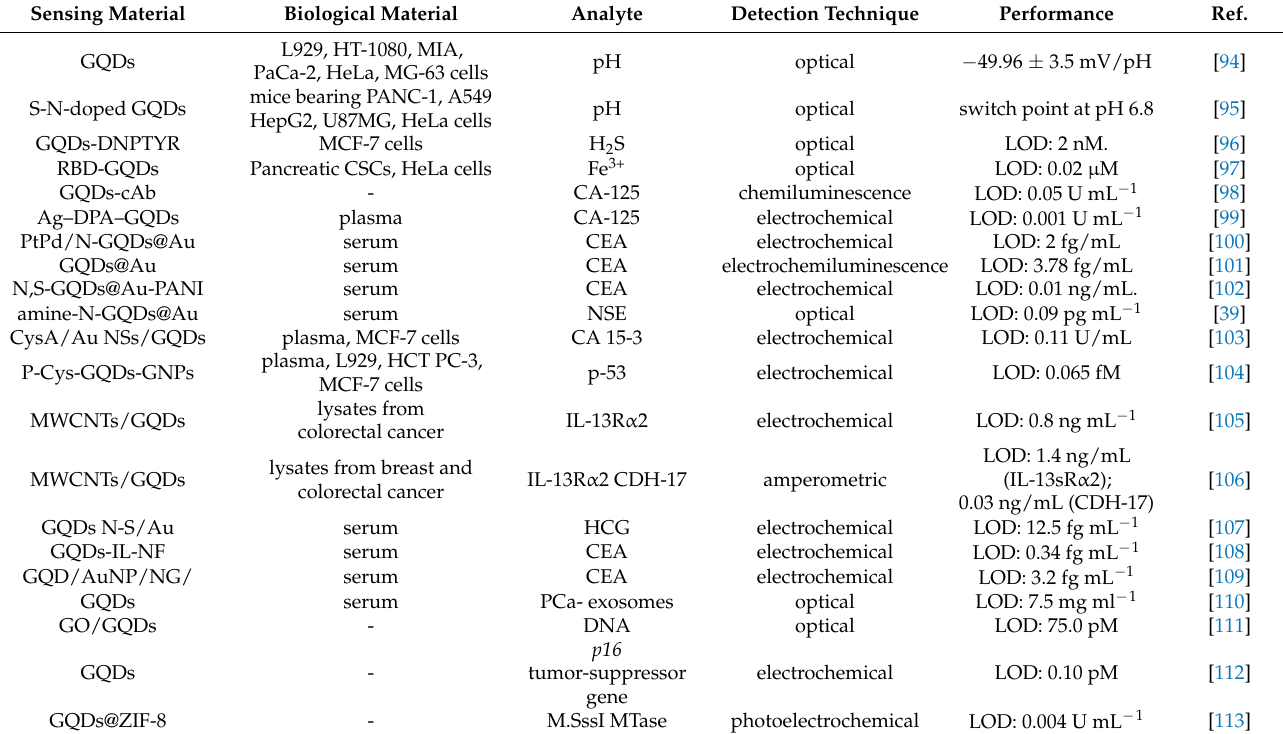
Table 2. Summary of some recent GQDs-based biosensors for cancer